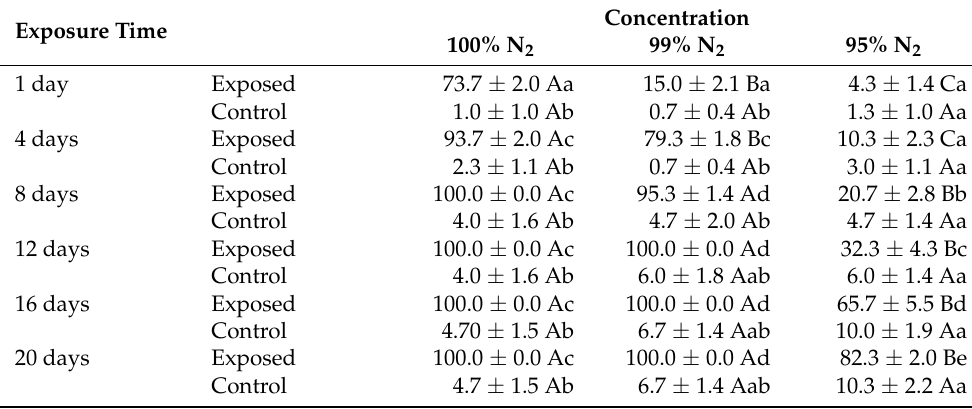
Table 2. Laboratory efficacy (% of mean adult mortality; Av. % ± SE) of six exposure times (ranging from 1 to 20 days) and three concentrations (ranging from 95% to 100% N 2 ) nitrogen-based controlled atmospheres on the exposed adults of grain weevil ( Sitophilus granarius ). (Different letters indicate statistically significant differences between